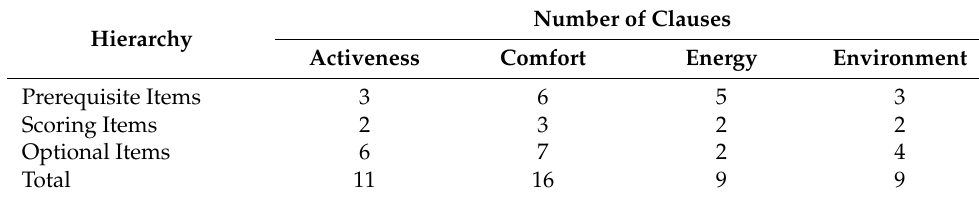
Table 4. Clause numbers of the